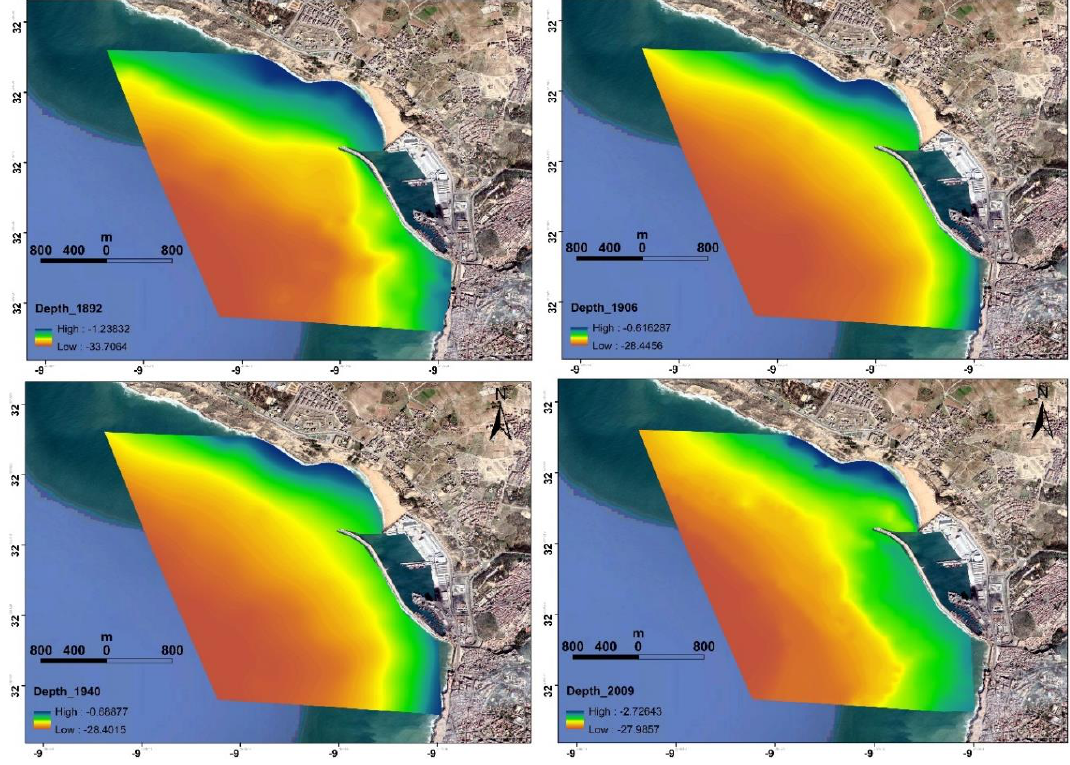
Figure 4. Interpolation maps of the bathymetry of the bay of Safi before, during and after the construction of the